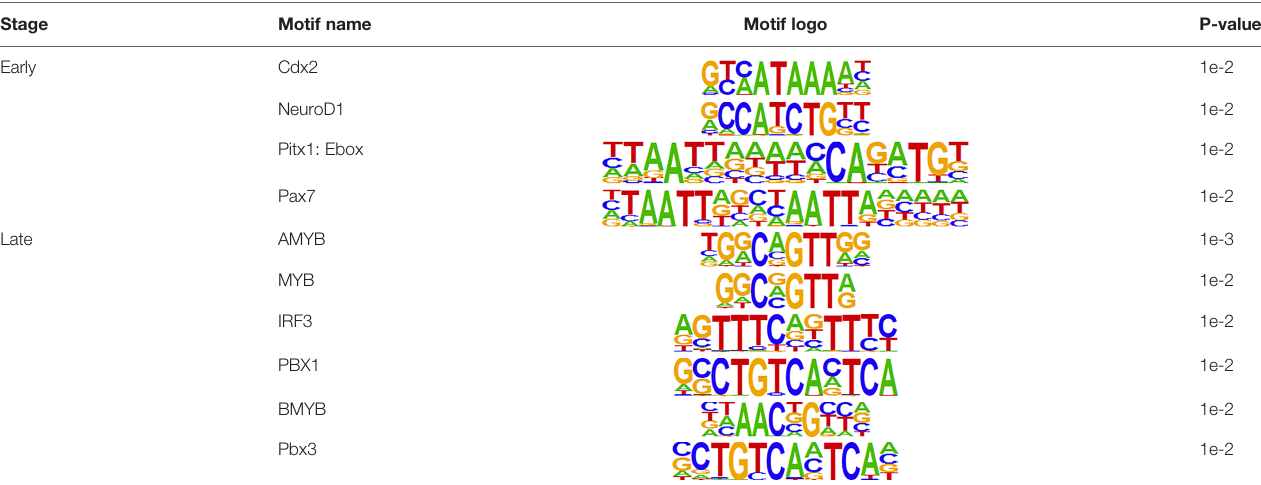
TABLE 2 | Motif analysis of the ATAC-seq peaks in ES and LS group of LUAD patients.